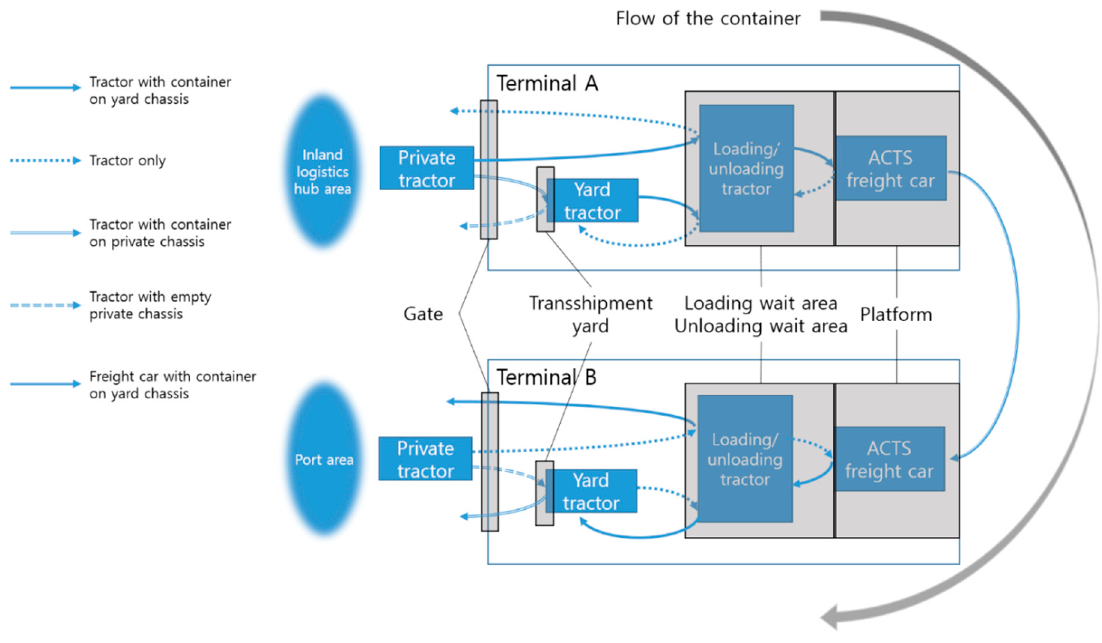
Figure 2. Freight transport system of ACTS.